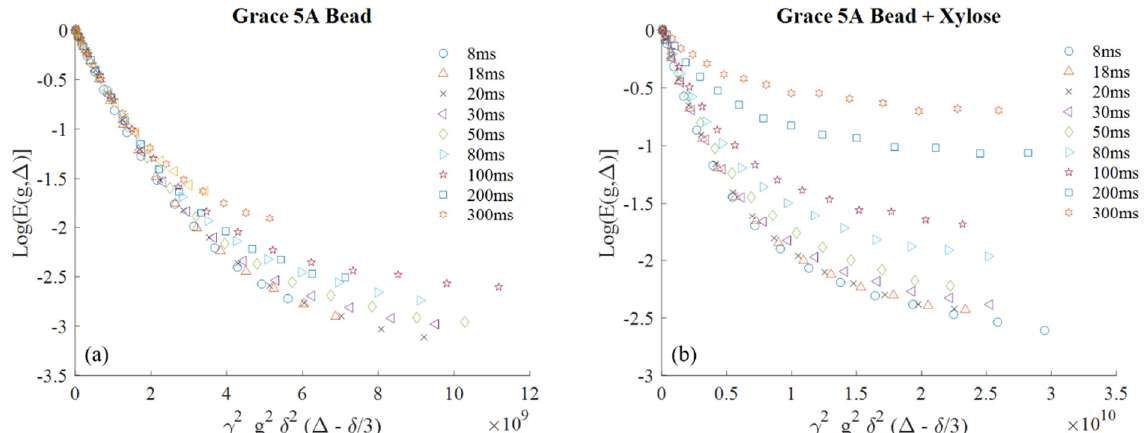
Figure 2. Stejskal–Tanner plots of Grace 5A beads ( a ) and Grace 5A beads with xylose ( b ) are shown. With increasing displacement observation time Δ from 8 to 300 ms, the attenuation of signal decreases for the pure water and xylose solution saturated beads. The gradient duration δ was 1 ms with a maximum gradient ranging from 0.500 to 1.9021 T/m in order to sample out to a similar point in the gradient domain. The data are well fit by a biexponential model with a fast and slow (cid:104) (cid:105) − D + p s exp [ − D s x ] . diffusion component p f exp f x